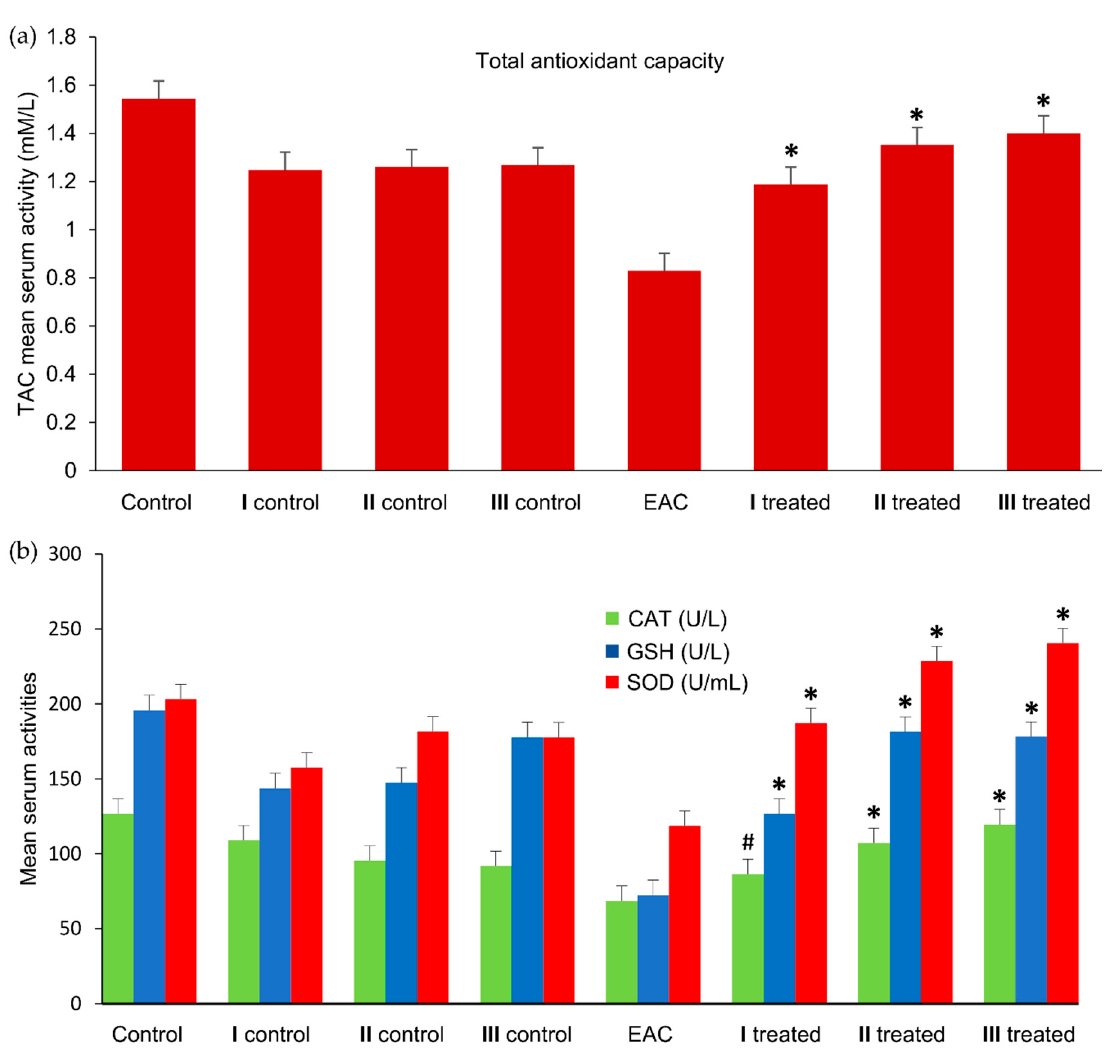
Figure 8. ( a ) Total antioxidant activity (TAC) and ( b ) catalase (CAT), superoxide dismutase (SOD), glutathione (GSH) activity in sera of healthy control, EAC, and treated groups. Values (columns and error bars) are expressed as mean ± SEM. # Indicates significant difference at p > 0.05, * indicates significant difference at p > 0.0001 as compared to the untreated EAC group.